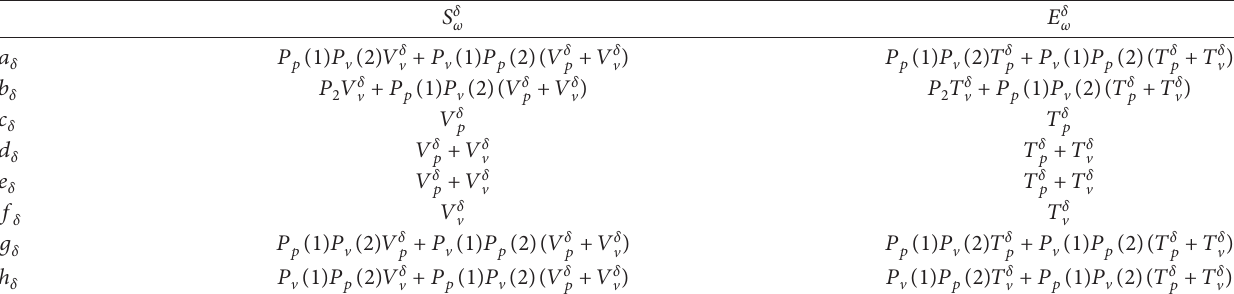
Table 4: Security and time payoff of pedestrian and